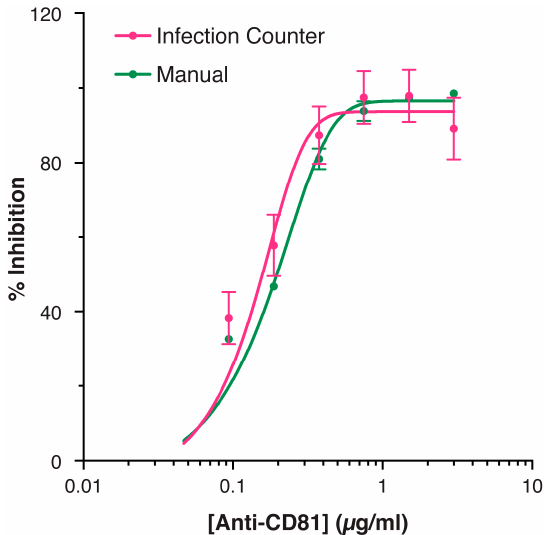
Figure 4. HCV receptor blockade by anti-CD81 monoclonal antibody (mAb). Huh-7.5 cells were pretreated for 1 h at 37 °C with a serial dilution of anti-CD81 mAb 2.20, after which the cells were inoculated with J6/JFH HCVcc in replicates of four. The cells were fixed after 48 h, stained for viral antigen and nuclear DNA, and imaged using a plate-reading fluorescence microscope. The infection in each well was quantified using the standard FFA (‘Manual’) and the proportion of infected cells was estimated using Infection Counter. The data is expressed as percentage of inhibition relative to Huh-7.5 cells treated with an irrelevant control mAb. Sigmoidal curves were fitted using non-linear regression (R 2 = 0.91 for both curves) and F-test comparison indicated no statistically significant difference between the manual and Infection Counter data ( p = 0.29). Error bars indicate standard deviation from the mean, n = 2.